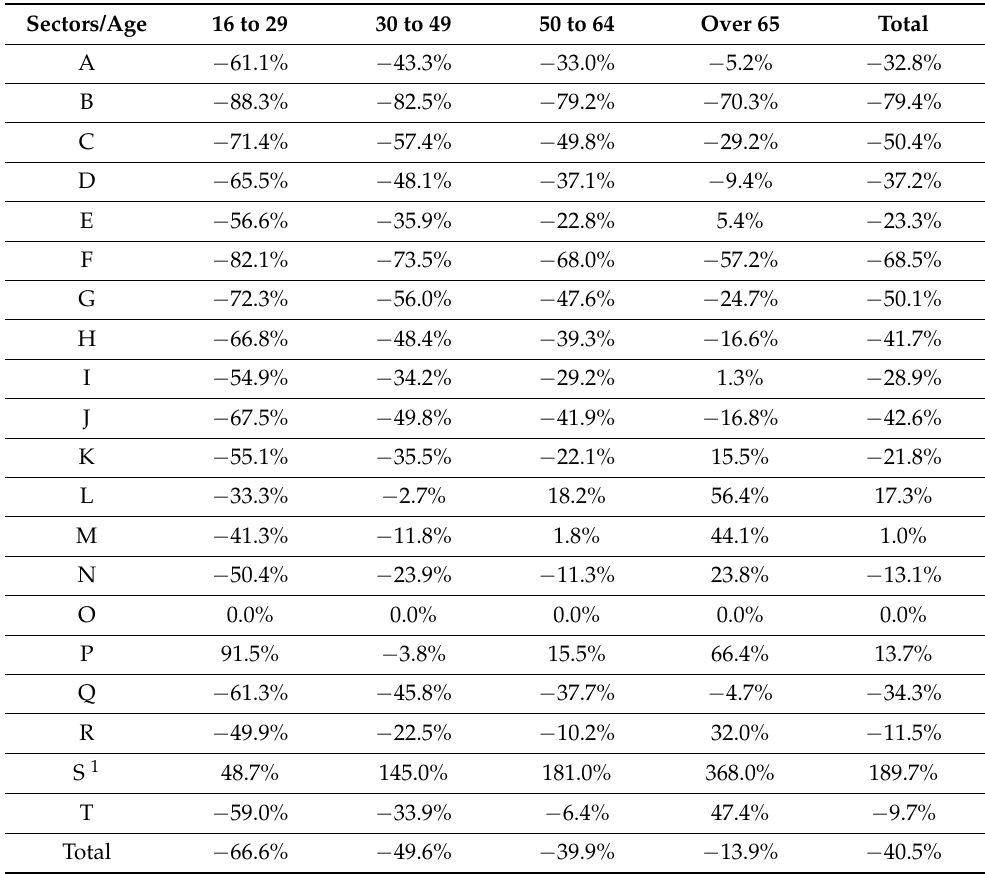
Table A3. Variation of CO 2 emissions associated with household consumption by age bracket and productive sector for 2005–2015